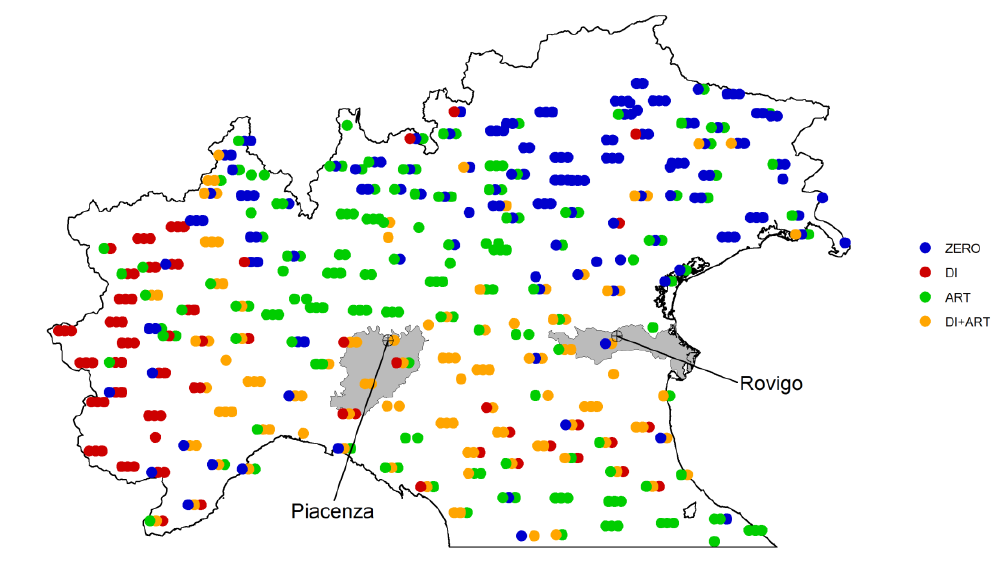
Figure 5. Detail of Figure 1 showing the positioning of Piacenza and Rovigo at the crossroad of the DI and ART isoglosses. The cities are marked by “circle plus” markers, while the provinces are shown as grey-filled